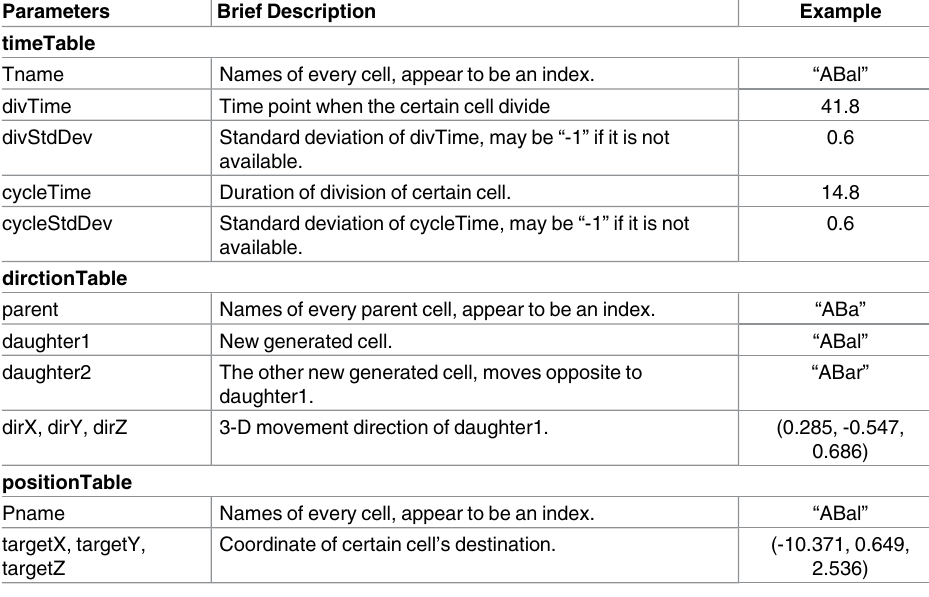
Table 3. Input parameters of each table and example values.